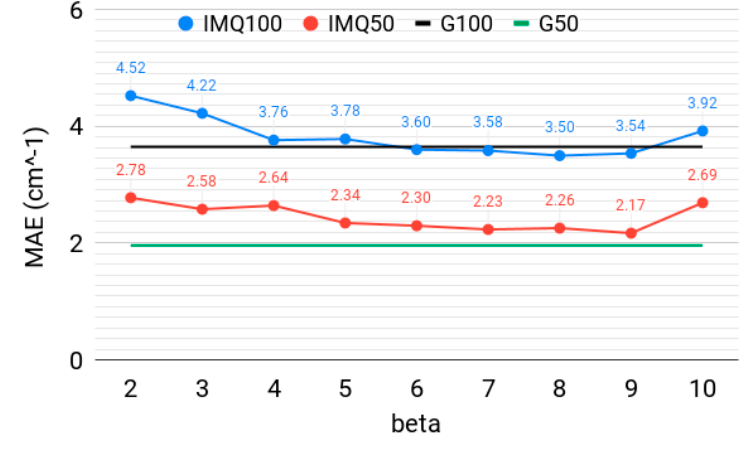
Figure 1. The mean absolute error (MAE), in cm − 1 , over the lowest 50 and 100 vibrational levels of H 2 CO, computed with the inverse multiquadratic (IMQ50, IMQ100) basis with different β (beta) parameters. The horizontal lines at 2 and 3.7 cm − 1 are corresponding values obtained with a Gaussian basis (G50, G100, respectively), as in Reference [30]. N = 20,000 basis functions and M = 80,000 collocation points were used.